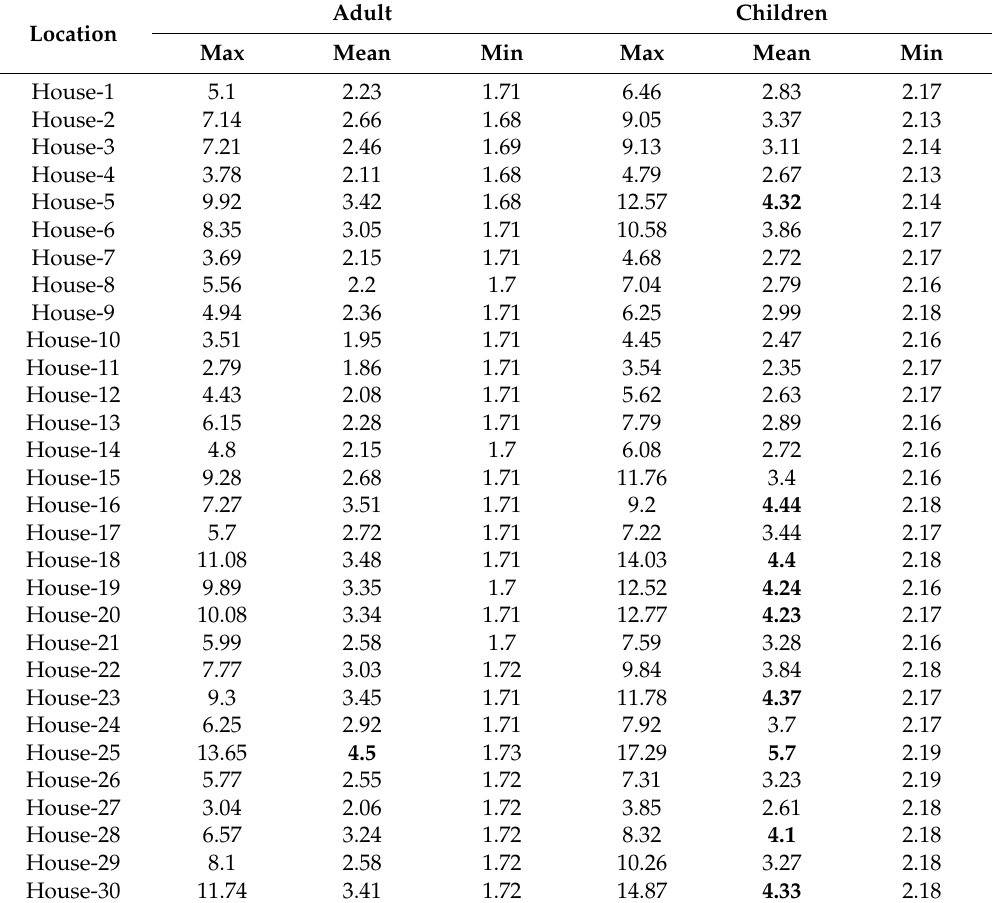
Table 4. Hazard Indices for adult and children in the sampled